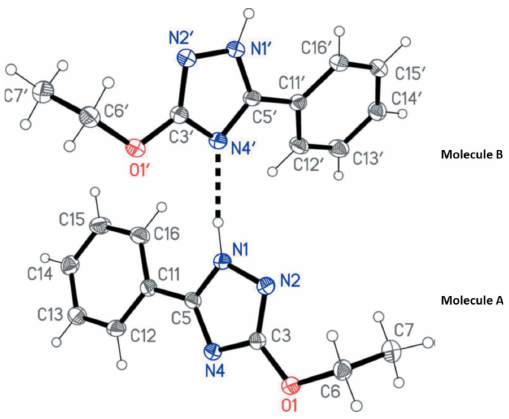
Figure 2 A view of the molecular structures of the two independent molecules of compound ( 7 ), with the atom numbering. Displacement ellipsoids are drawn at the 50% probability level. The dashed line indicates a classical hydrogen bond (Table 1).